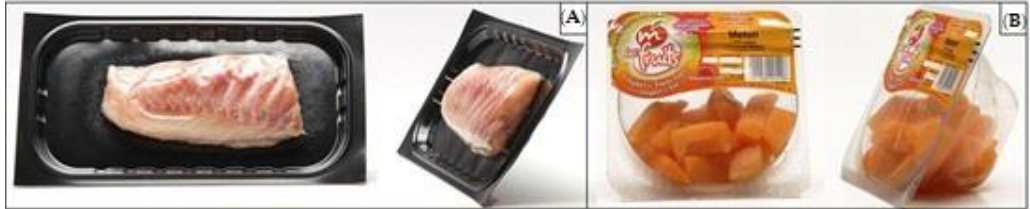
Figure 1. Illustrations of ( A ) Vacuum-skin packaging (VSP) and ( B ) biodegradable modified atmosphere packaging (BioMAP) and modified atmosphere packaging (MAP) systems using fish and fruit as examples of packaged goods. Source: [13].